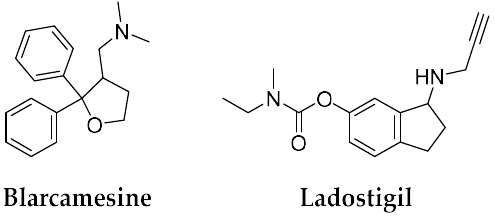
Figure 8. Structures of multi-target-directed ligand targets for